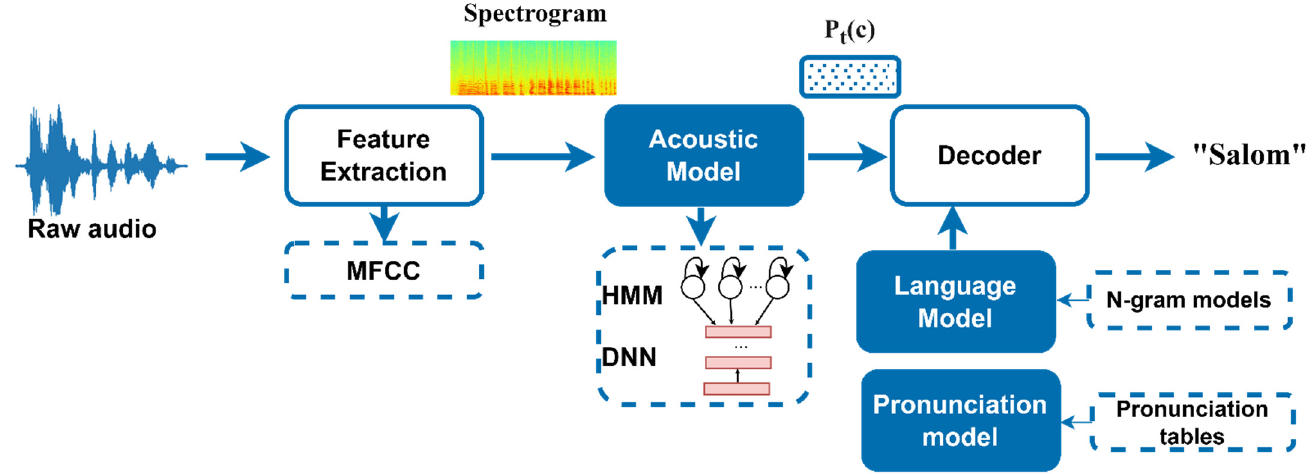
Figure 2. Overview of the proposed Uzbek language ASR system.